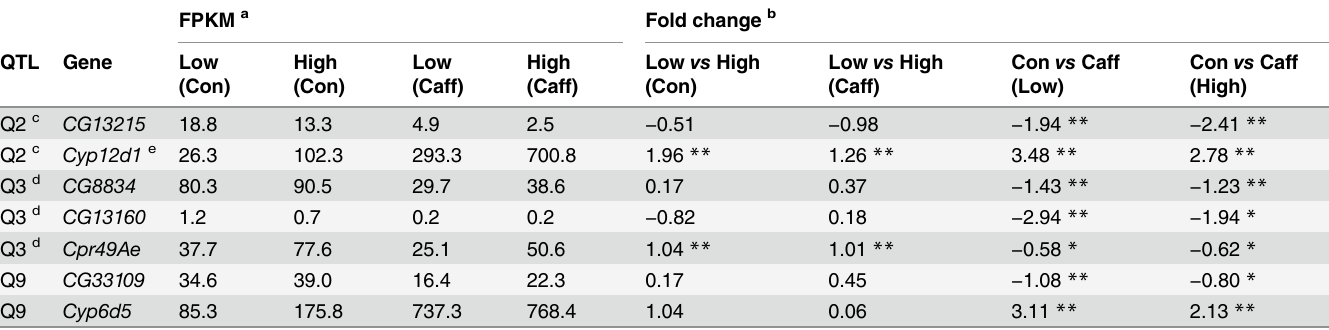
Table 2. Differential expression of genes beneath QTL mapped in